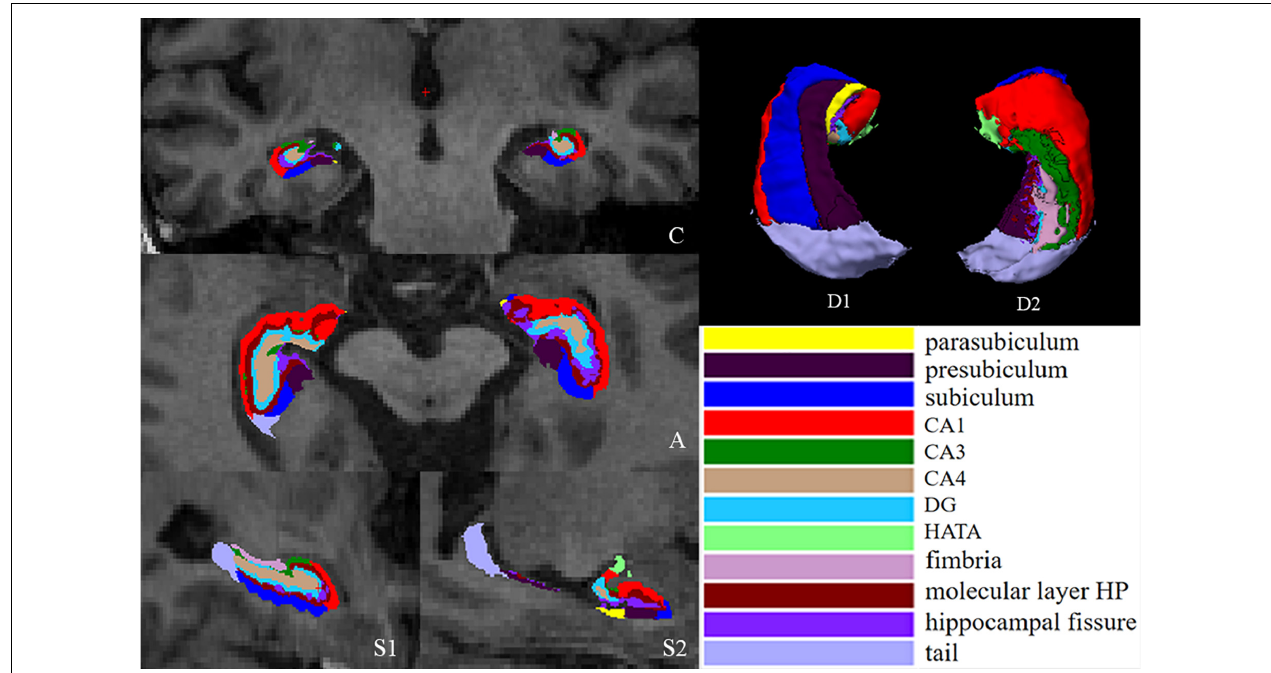
FIGURE 1 | Segmentation of hippocampal subfields. (C) Coronal slice, medial view. (A) Axial slice, medial view. (S1) Sagittal slice, medial view. (S2) Sagittal slice, lateral view. (D1) 3D rendering of segmentation, inferior view. (D2) 3D rendering, anterior view. CA, cornus ammonis; DG, dentate gyrus; HATA, hippocampal amygdalar transition